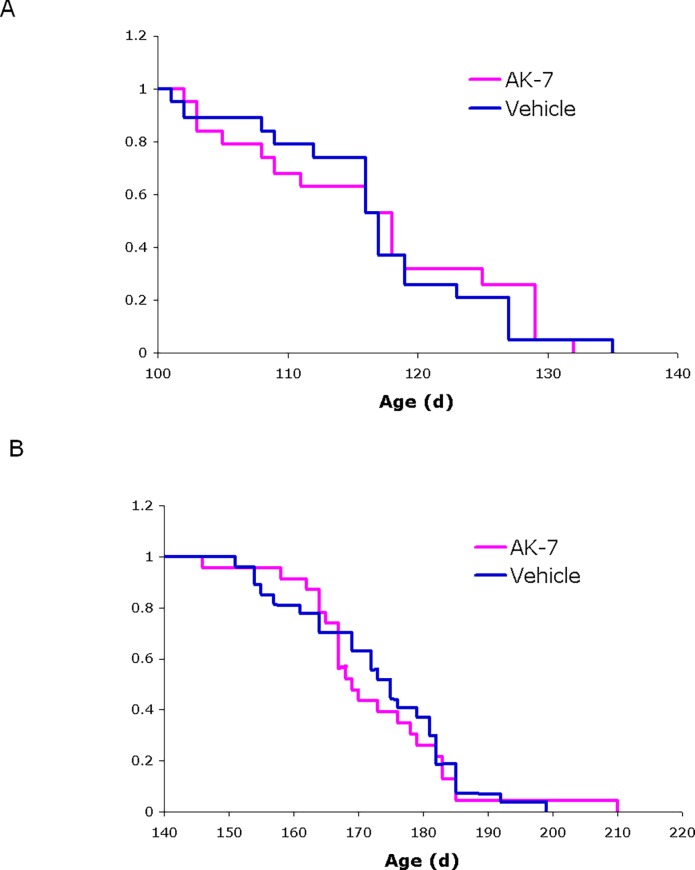
Effects of AK7 in SOD1-G93A mouse model of ALS.Kaplan-Meier probability curves show no significant effects of AK7 treatment on (A) symptom onset (118 ± 10.0 days for AK7, 117 ± 8.6 days for vehicle-treated controls) or (B) survival (169 ± 12.7 days for AK7, 175 ± 12.4 days for controls) of SOD1-G93A mice in this study. Values are median age ± SD; n = 23 for AK7, n = 27 for vehicle-treated controls.